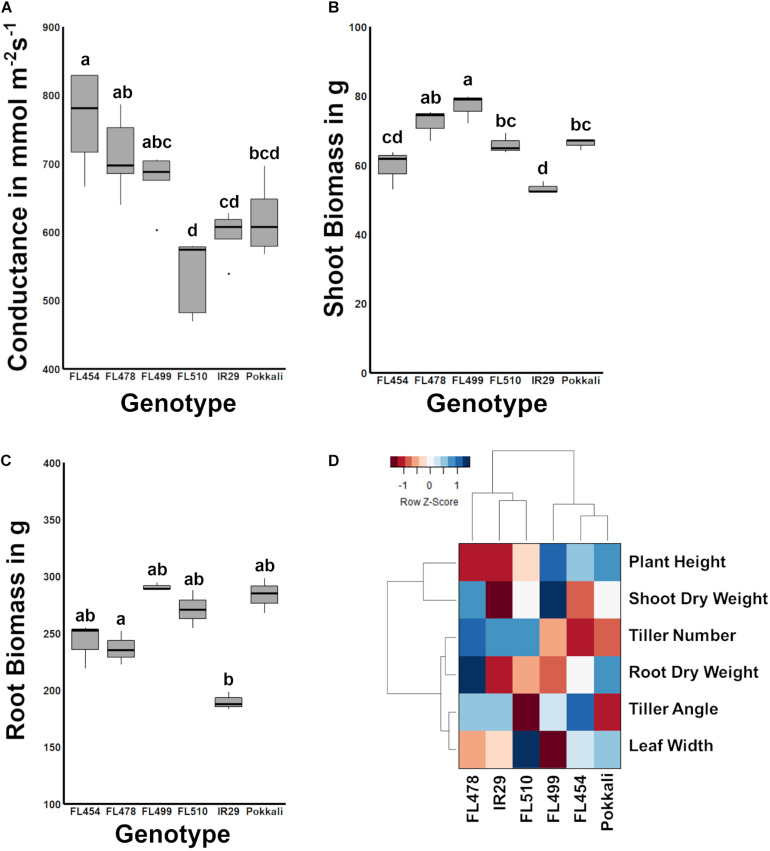
Comparison of stomatal conductance and biomass potential across the IR29 × Pokkali comparative panel, and measure of overall relatedness across the panel based on morpho-developmental and physiological profiles. (A) The width of leaf blades and tiller angle consequently affect transpiration. FL510, which had the smallest tiller angle and broadest leaf blades also had the smallest mean stomatal conductance, significantly lower than the other recombinant inbred lines (RILs; P < 0.05). While the stomatal conductance of FL510 was not statistically different from IR29 and Pokkali, it was lowest mean among the genotypes. (B) Shoot biomass indicated that FL510 had smaller exposed surface area compared to the other genotypes, while its shoot dry weight was comparable to the other genotypes. (C) Root biomass was not significantly different among the different genotypes, indicating that the difference in architecture is mainly due to shoot growth. (D) Hierarchical clustering dendrogram of morpho-physiological traits highlighting the similarity of FL510 and FL478 to IR29, and the similarity of FL454 and FL499 to Pokkali. The heatmap summarizes the widest deviation of FL510, which lie on its wider leaves and lesser tiller angle, to the common architecture of FL478 and IR29.